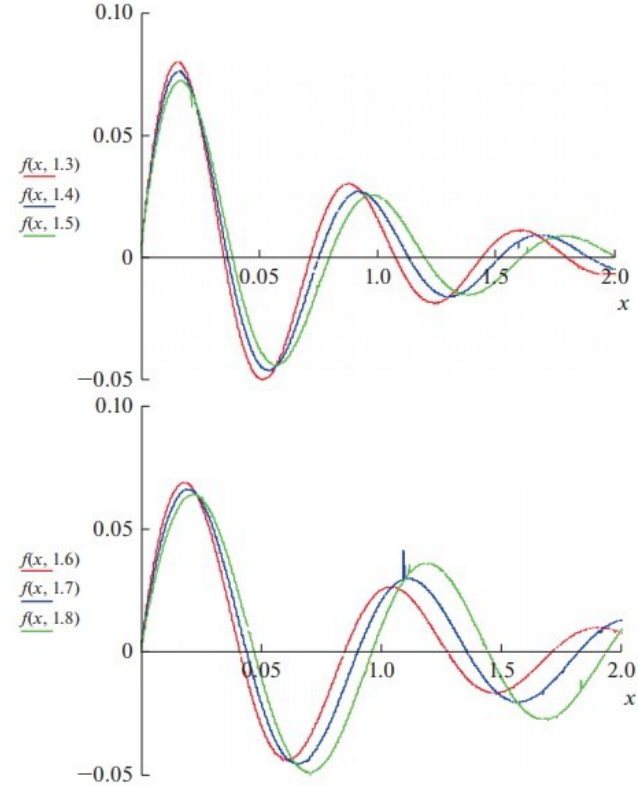
Figure 1. Graphs of solutions when 1 < α < 2.